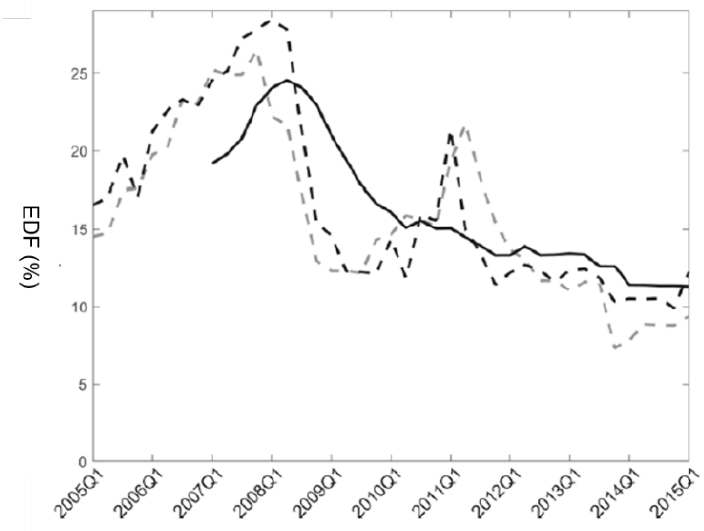
Fig. 5 Sihuan Pharmaceutical Co., Ltd. EDF. EDF, expected default